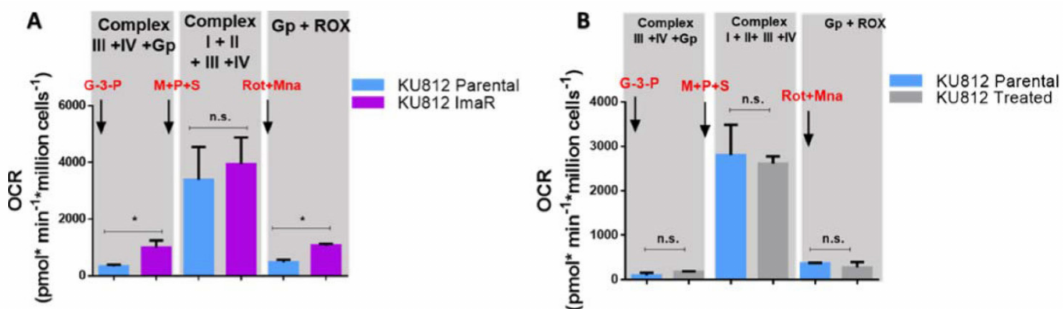
Figure 8. Contribution of glycerol-3-phosphate shuttle to the mitochondrial respiration of KU812 imatinib-treated or KU812 imatinib-resistant vs. KU812 Parental cells. ( A , B ) OCR measurements of KU812 imatinib-resistant (ImaR) vs. KU812 Parental (P) (Panel A ), and KU812 Treated (KU812 P cells treated with 80 nM imatinib for 72 h under normoxic conditions) vs. KU812 P cells (panel B ) determined under normoxia by Oroboros Oxygraph-2k respirometer. OCR were measured after sequential injections of 10 mM Gp + 5 mM ADP, 10 mM succinate + 5 mM pyruvate + 2 mM malate, 5 mM malonic acid, and 0.5 µ M rotenone + 2.5 µ M antimycin. Data were normalized by cell number. Data are provided as mean ± SD of n = 3 and significance was determined by two-tailed independent sample Student’s t -test. Statistically significant di ff erences between KU812 Parental and KU812 ImaR cells were indicated as * p < 0.05 and p ≥ 0.05 (n.s. = non-significant di ff erences). Abbreviations: G-3-P, glycerol-3-phosphate; P, pyruvate; M, malate; Mna, malonic acid; Rot, rotenone; and S,